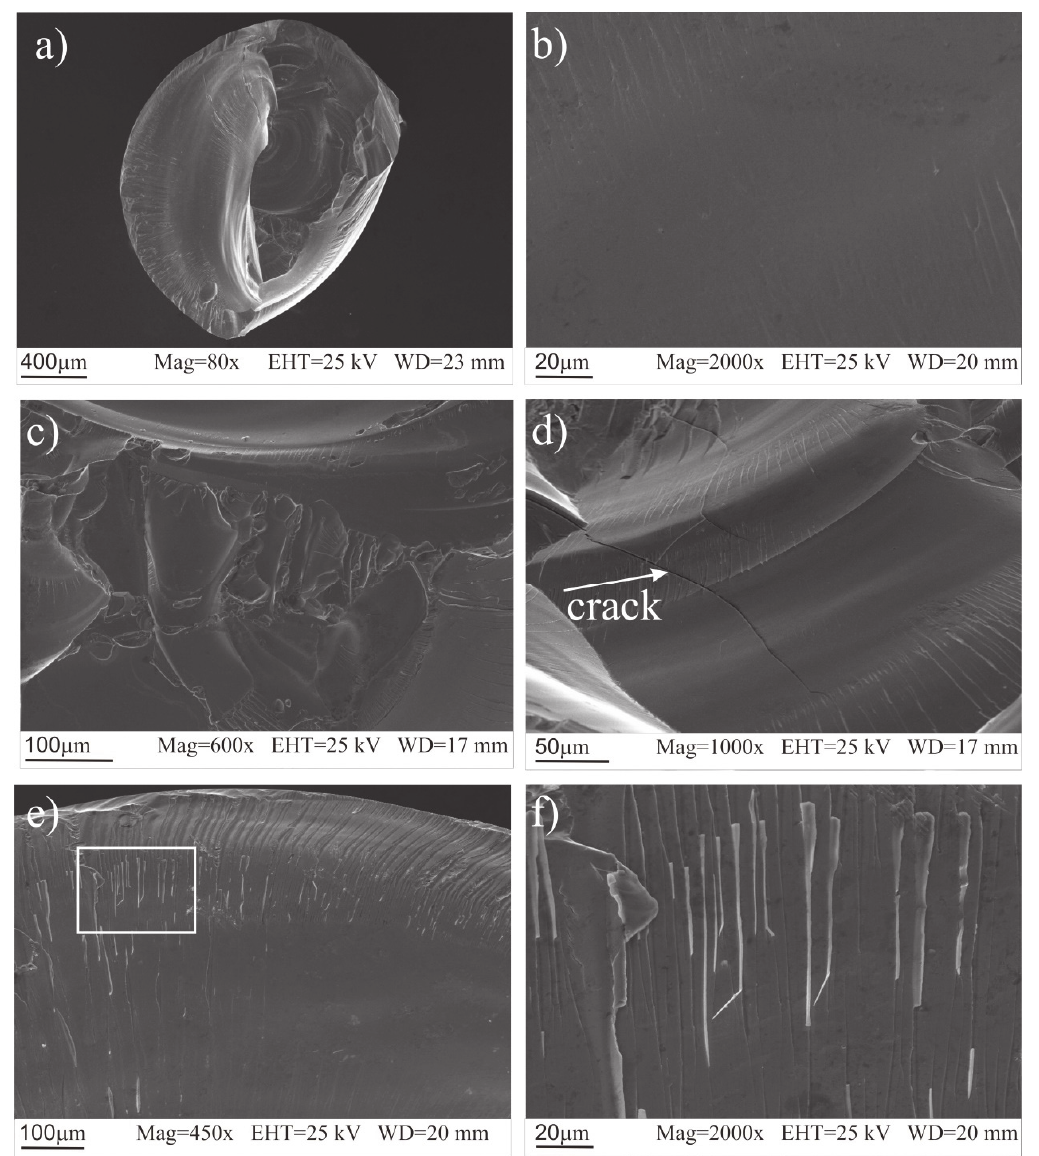
Figure 4: SEM images of the fracture morphology of Fe 36 Co 36 B 19 Si 5 Nb 4 alloy rod with diameter of  =3 mm after compressive fracture; a – main view: smooth and vein pattern regions, b – image of fracture near the core of rod, smooth patterns, c, d – image of fracture near the core of rod, smooth and vein pattern regions, crack is indicated by arrow (d), e, f – image of fracture outside surface, vein and smooth patterns, f – image showing veins, as indicated by the rectangle in (e) at higher